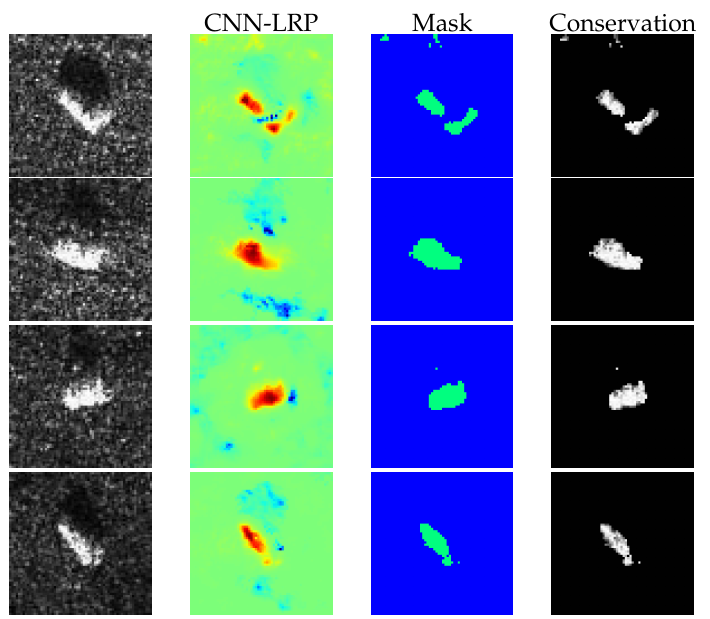
Figure 10. Results of conservation. The first column is SAR images of four classes: 2S1, ZSU_23_4, D7, T62. The second column is heatmaps generated by our method. The third column is binary mask. The fourth column is conservated images.